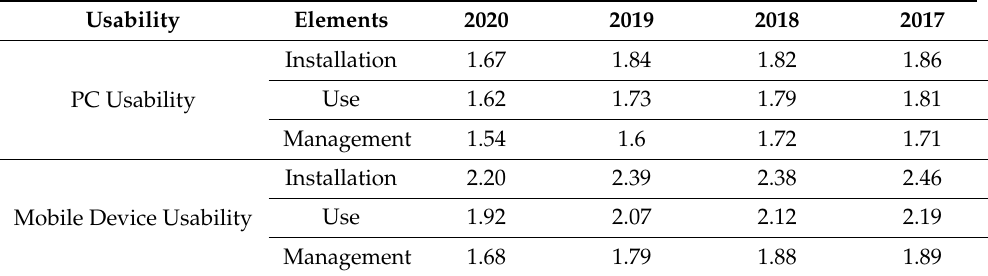
Table 5. Level of 3 Subelements of Information Capability of Older People (4-point Scale).